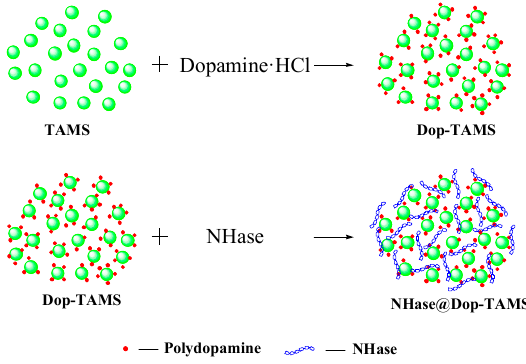
Figure 1. The reaction scheme for immobilization of NHase in dopamine-functionalized tannic acid-templated mesoporous silica (Dop-TAMS).